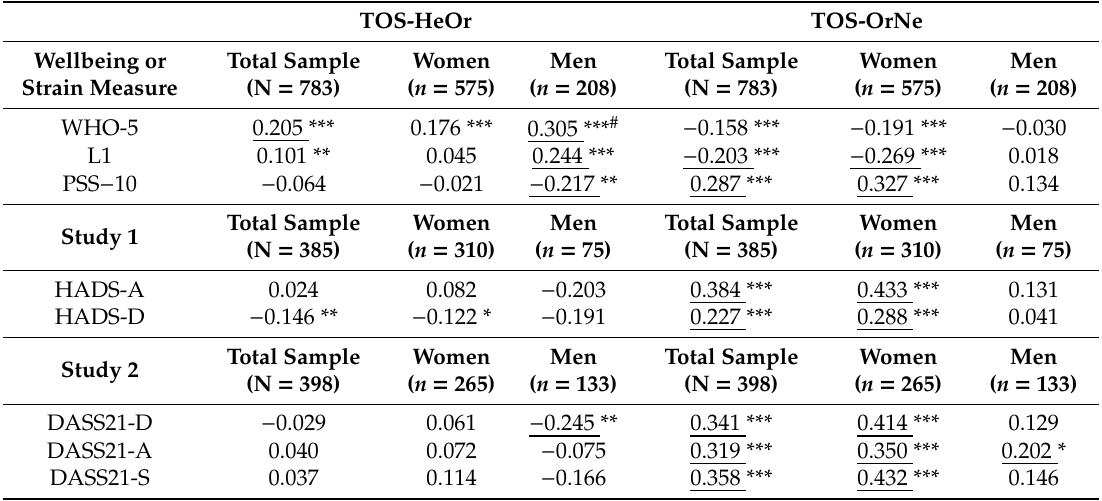
Table 3. Associations between orthorexic eating and mental health